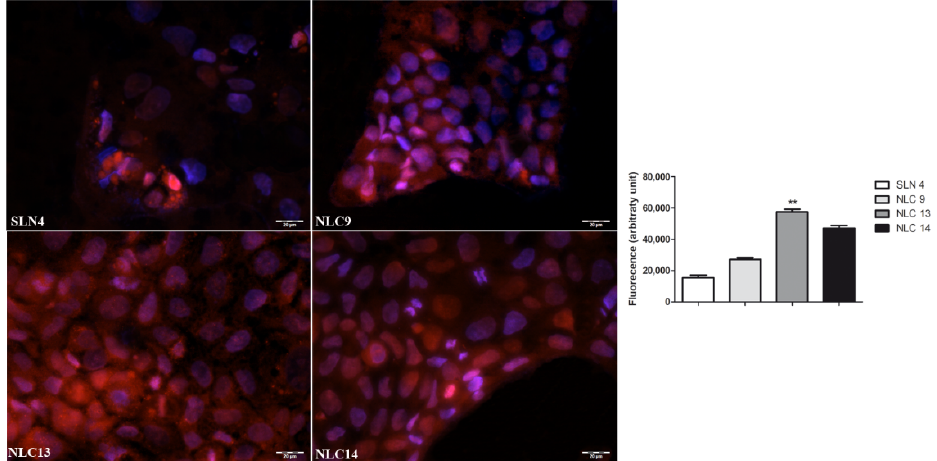
Figure 7. Cellular uptake of rhodamine-labeled SLN and NLC in Caco-2 cells after 1 h of exposure at 37 °C. Nuclei stained with DAPI. Final magnification 20×, scale bar 50 µm. Results expressed as mean ± SEM, n = 10; ** p < 0.01 vs. SLN4 (Kruskal–Wallis test and Dunn’s multiple comparisons test).